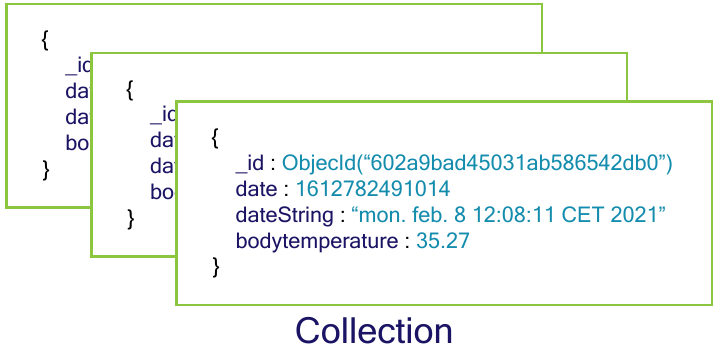
Figure 5. Example of database collection in the